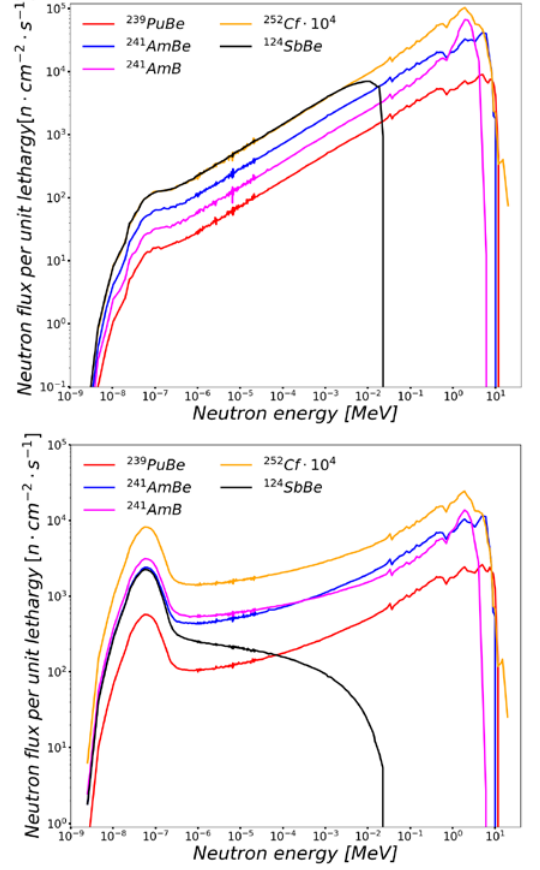
Fig. 2 – Un-moderated (up) and moderated with 4.5 cm of polyethylene (down) neutron source spectra at the detector’s position. T ABLE 2 – REACTION RATES FOR DIFFERENT MODERATED (M - 4.5 CM ) AND NONMODERATED (NM) NEUTRON SOURCES